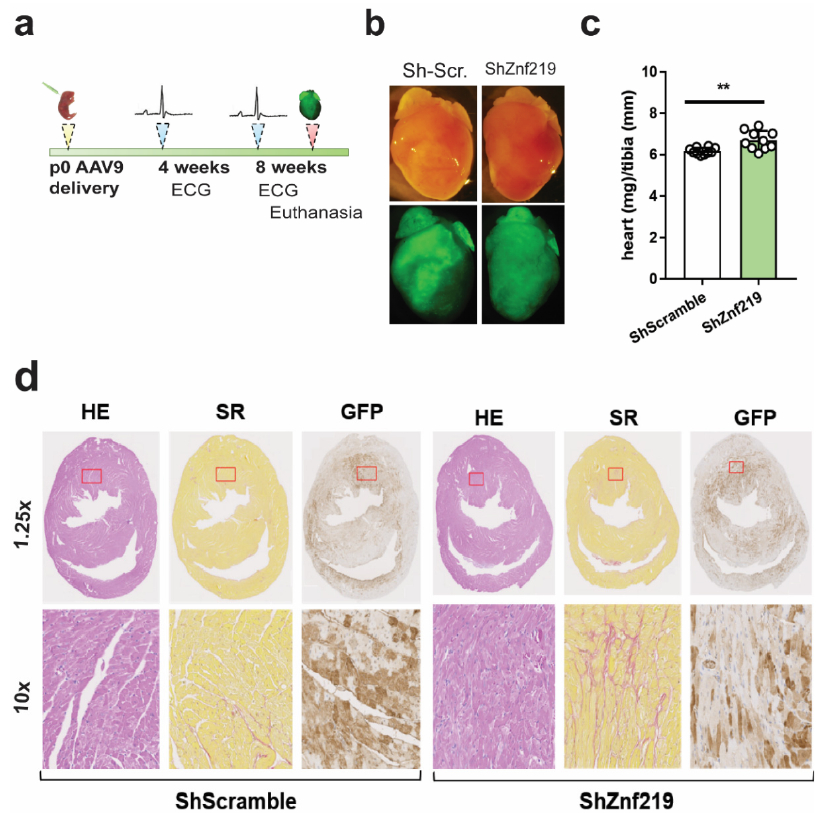
Figure 3. Znf219 regulates heart homeostasis in vivo. ( a ) Schematic representation of the experimental design after subcutaneous AAV9 injection into CD1 PD1-2 pups. ( b ) Gross morphological appearance of whole hearts of 8-week-old infected mice (upper panels) and fluorescence microscopy showing GFP expression in both atria and ventricles (lower panels). ( c ) Heart weight/tibia length ratios in infected mice. Paired t -test (two-tailed), ** adj. p -value <0.01. ( d ) H&E (HE), Sirius Red (SR), and GFP staining on transverse heart sections from 8-week-old infected mice. Hearts were infected with 2 × 10 11 particles of AAV9-shRNA-Scramble (left) or 2 × 10 11 AAV9-shRNA-Znf219 (right). Mice infected with shRNA-Znf219 show interstitial fibrosis (middle right). ShRNA-Scramble (n = 9); shRNAZnf219 (n = 13).